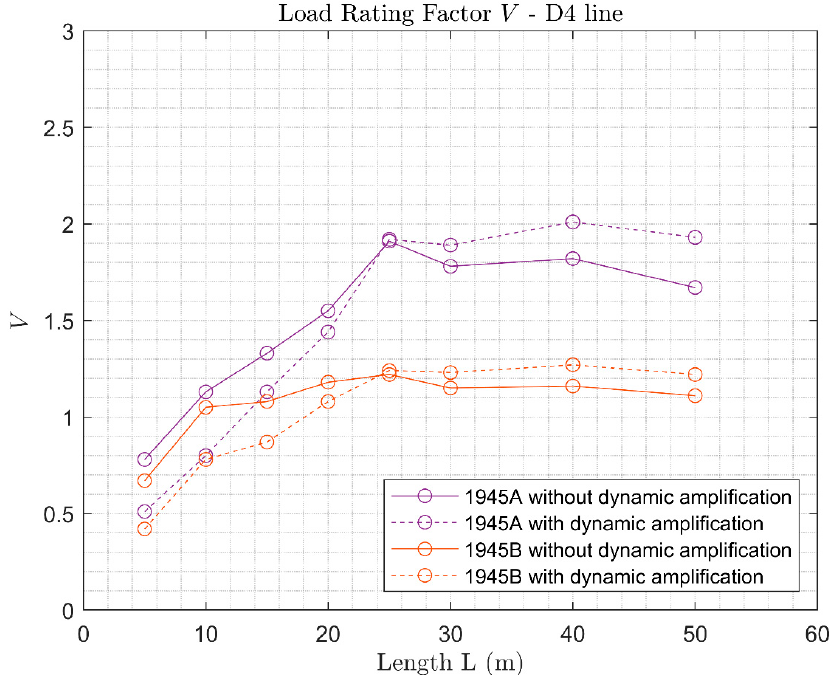
Figure 19. Load Rating Factor of arches designed according to the 1945 codes and verified with D4 loads, both with and without dynamic amplification comparison.